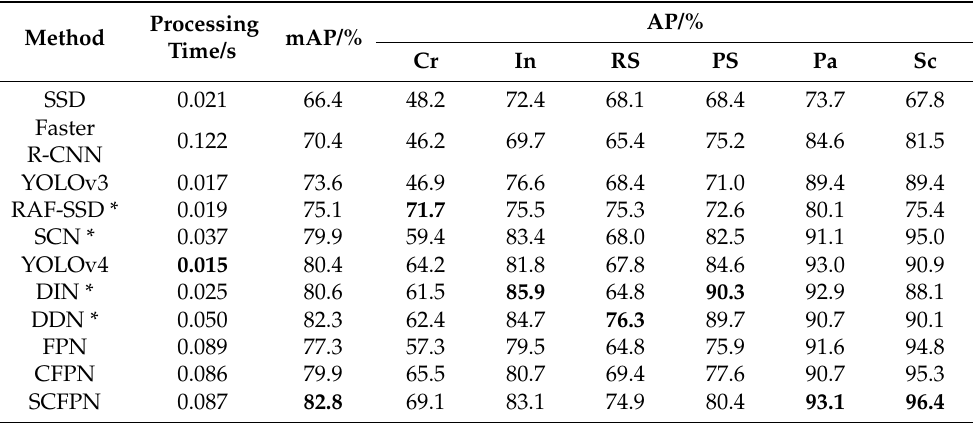
Table 3. Experimental evaluation metrics of different detection networks on NEU datasets. Exper- imental results from methods without “*” are rerun by ourselves, and experimental results from methods with “*” are cited from published papers. The bolded values are the best results in their respective columns. AP/% Processing Method mAP/% Time/s Cr In RS PS